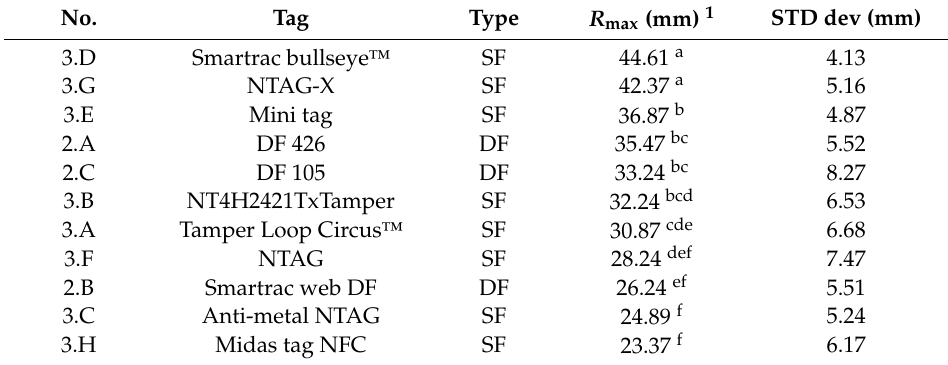
Table 10. Maximum scan distance ( R max (mm)) means of the NFC tags attached to a meat patty (mm). The data show the means for the two considered smartphone